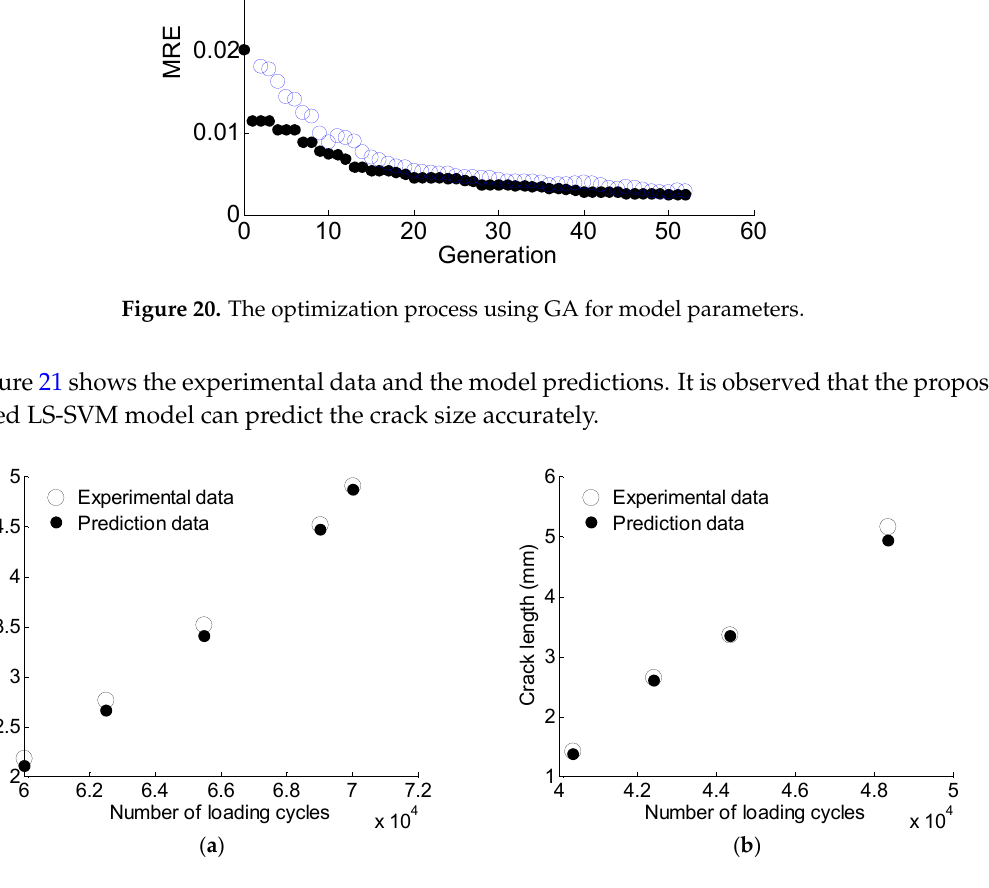
Figure 21. The prediction results for S1 and S5 using GA based LS-SVM. ( a ) S1; ( b ) S5.